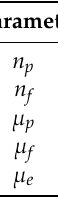
Table 8. The parameter setting of the